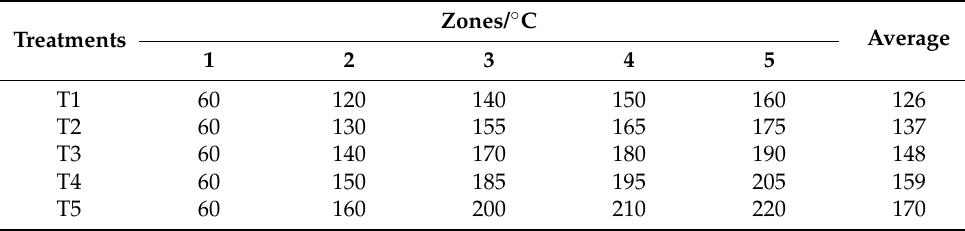
Table 1. Temperature profile in the extruder zones.